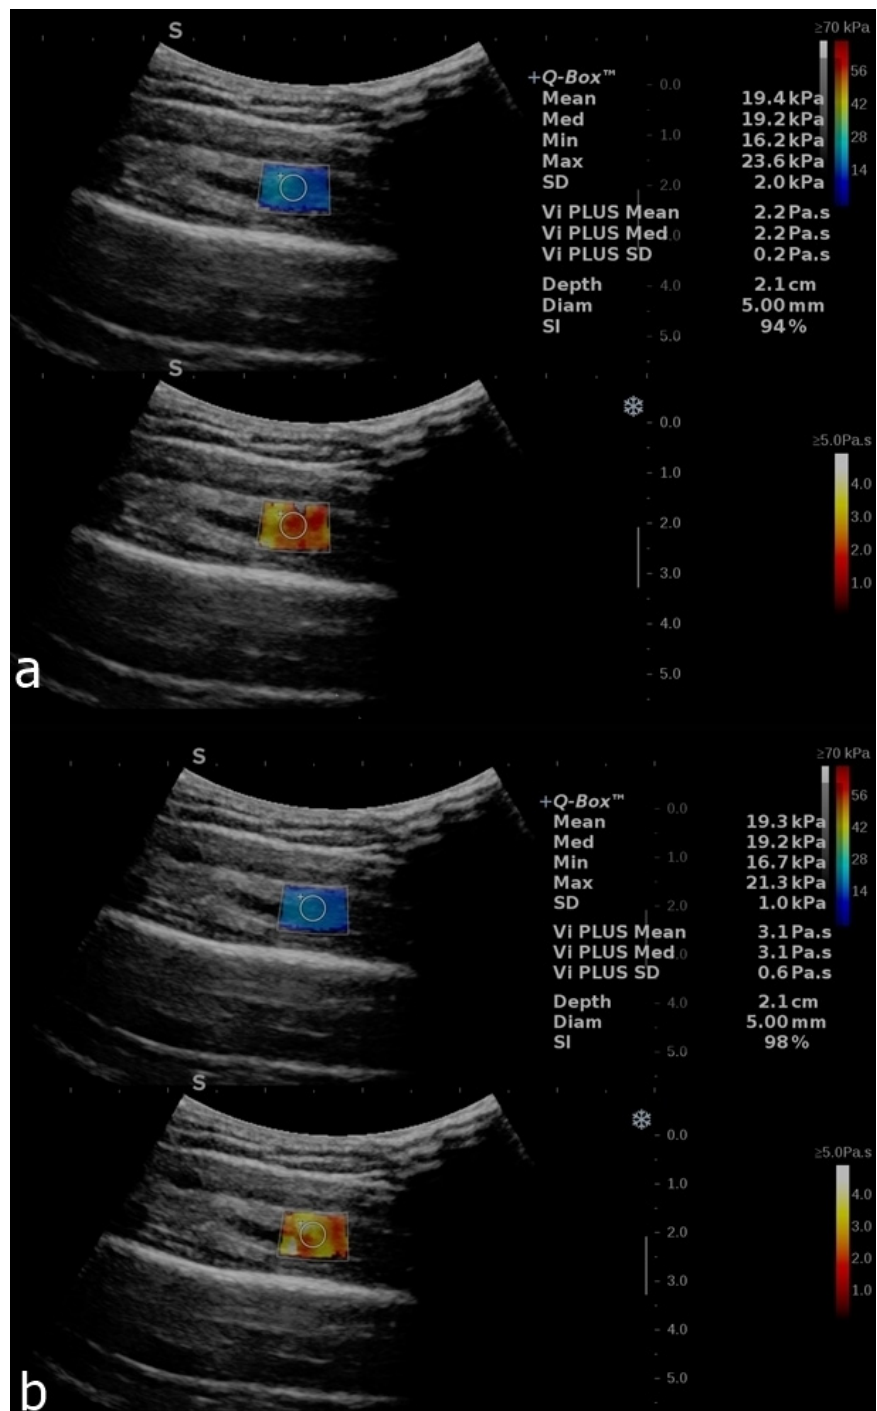
Figure 3. B-mode image with an elastogram of the deltoid muscle in a healthy volunteer. Longitudinal plans of the deltoid muscle as follows: relaxed ( a ) and after contraction ( b ). The regions of interest (ROIs) were placed in the box when the homogenous coloring of the box was obtained with a stability index of over 90%. The top image in each set reflects the SWE mode, and the bottom image reflects the ViPLUS application. ROI values are expressed in kPa for SWE and Pa.s for ViPLUS.